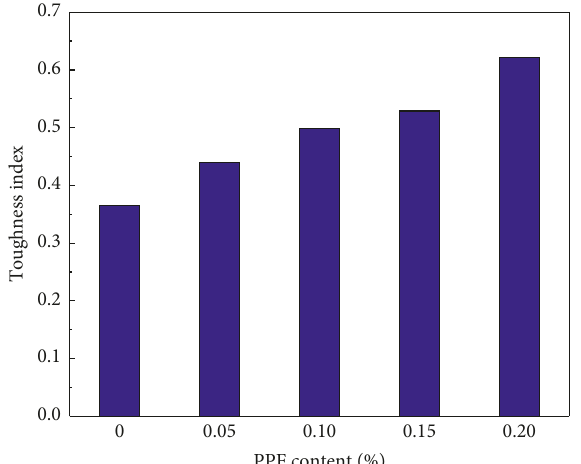
Figure 10: Evolution of the toughness index of AAS mortars as a function of PPF content.